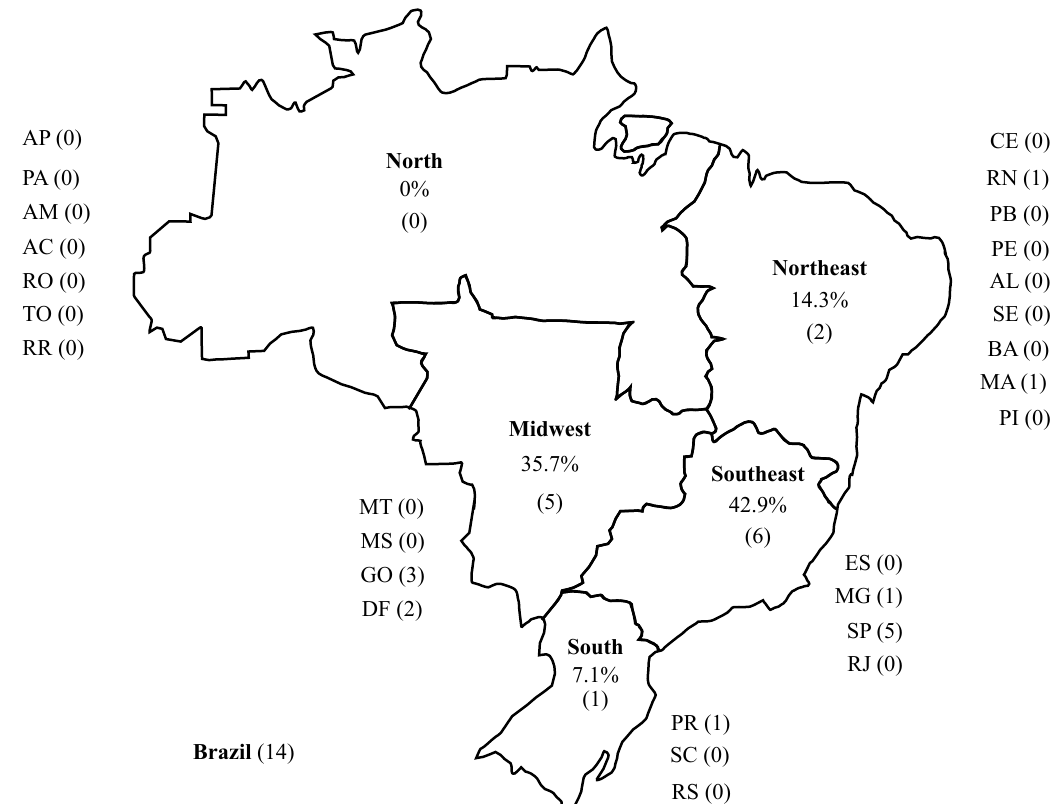
Figure 1. Geographic distribution in January 2017 of the Brazilian research groups on dietary interventions and physical exercise in cancer by region (in percentage) and federation state (in frequency).